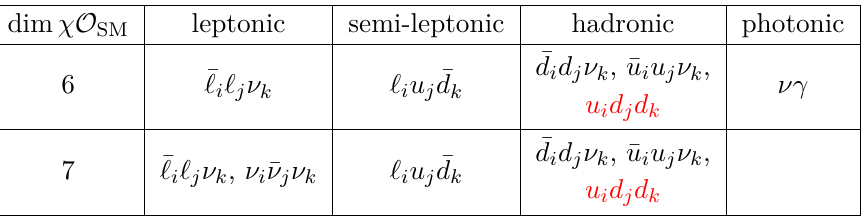
Table 2 . Summary of final states generated in ν SMEFT for spin-1/2 LLP decay for different operator dimensions. Final states highlighted in red violate global SM symmetries B or B − L . Dimension 7 operators with covariant derivatives can also generate final states with an additional gauge boson γ or g